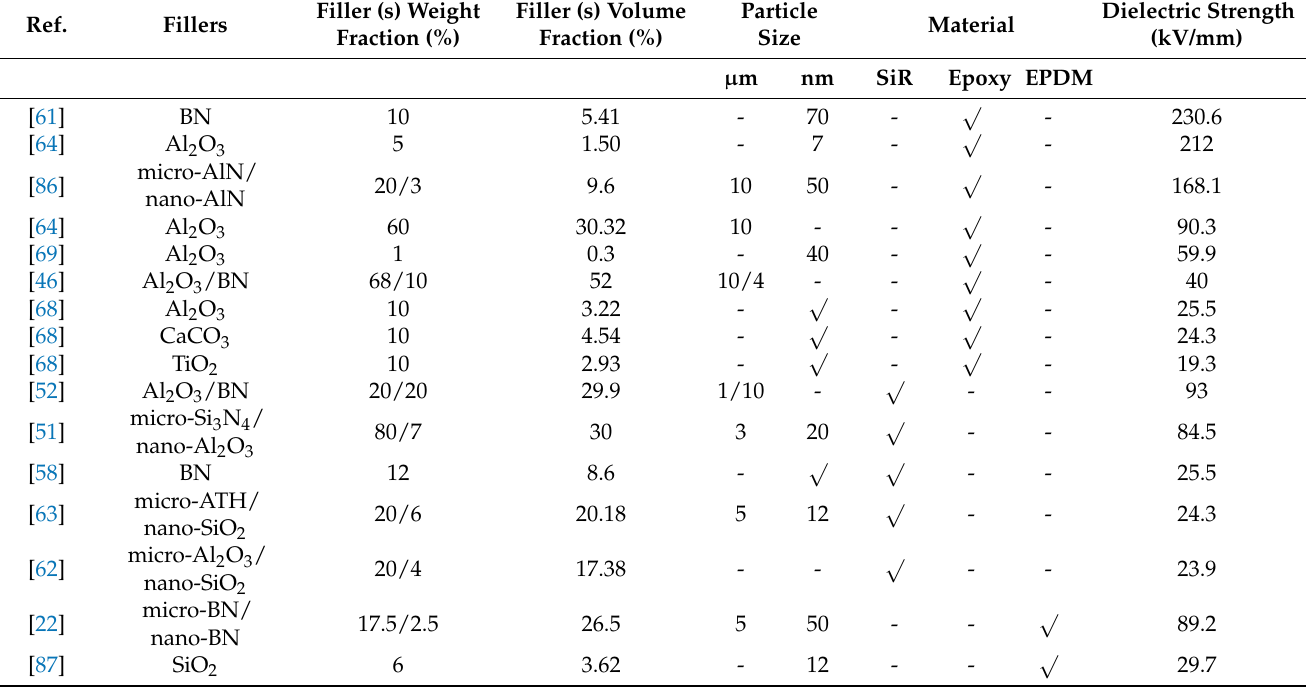
Table 3. Increased dielectric strength of polymer matrix by adding different fillers. Ref.